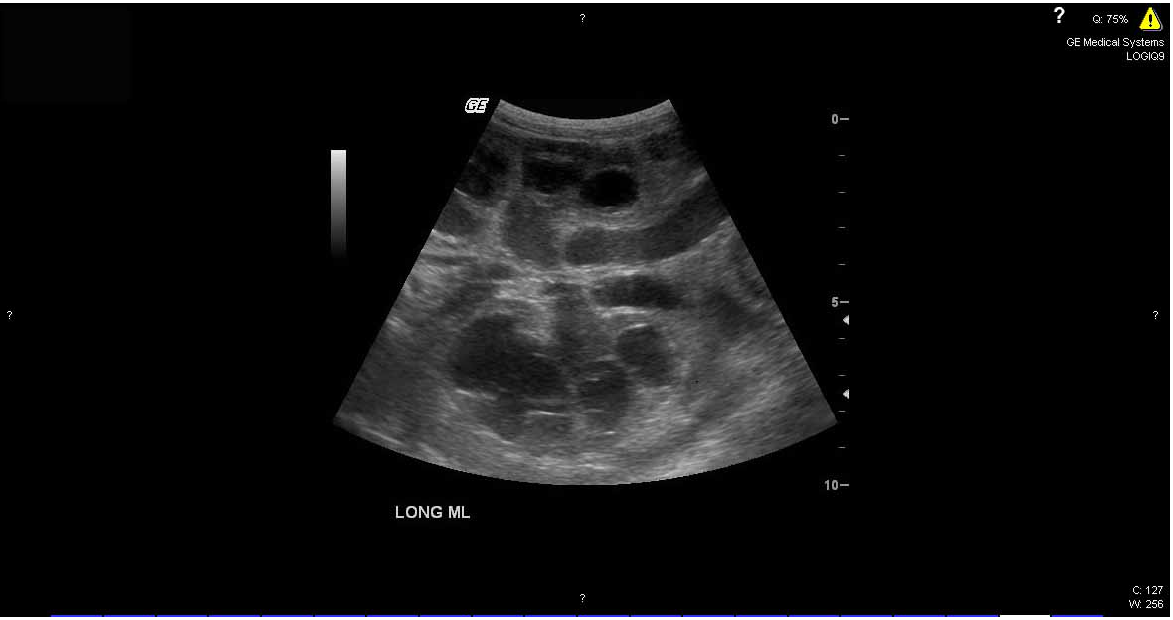
FIGURE 6C. Abdominal ultrasound demonstrating bilateral hydroureteronephrosis in a neonate with posterior urethral valves.